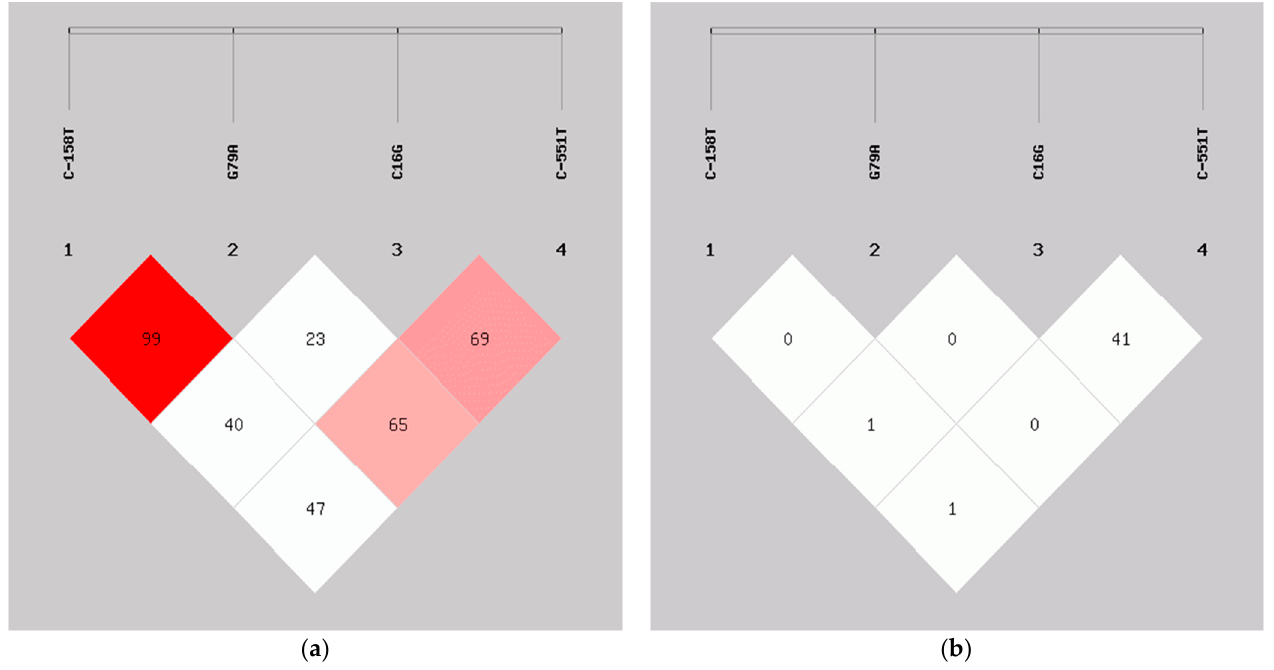
Figure 1. Degree of linkage disequilibrium of the β -like globin SNPs. ( a ) Values in the LD blocks indicated the D’ in percentage; ( b ) Values in the LD blocks represented the r 2 in percentage.